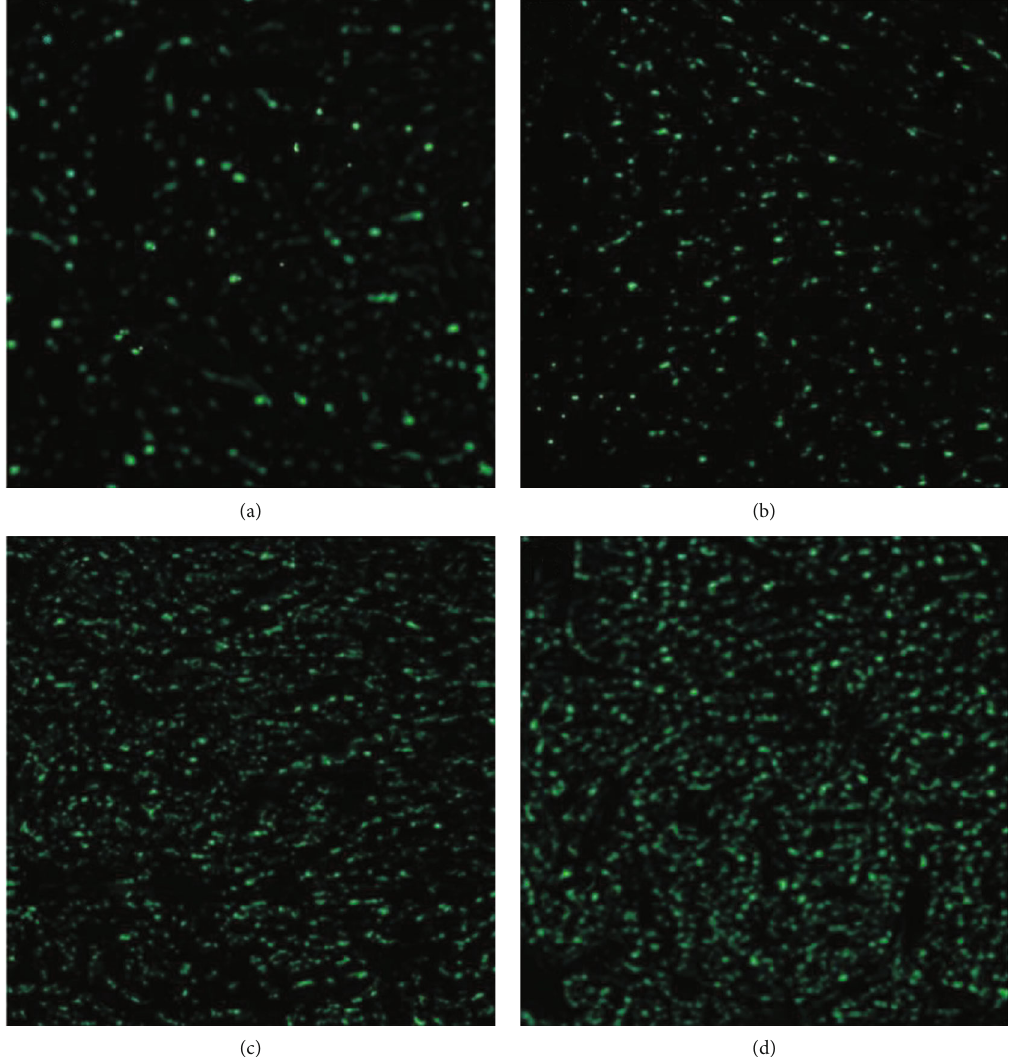
Figure 2: Cardiomyocyte apoptosis. (a) Control group. (b) Paclitaxel (PTX) 50 μ g/50g group. (c) PTX 100 μ g/50g group. (d) PTX 150 μ g/ 50g